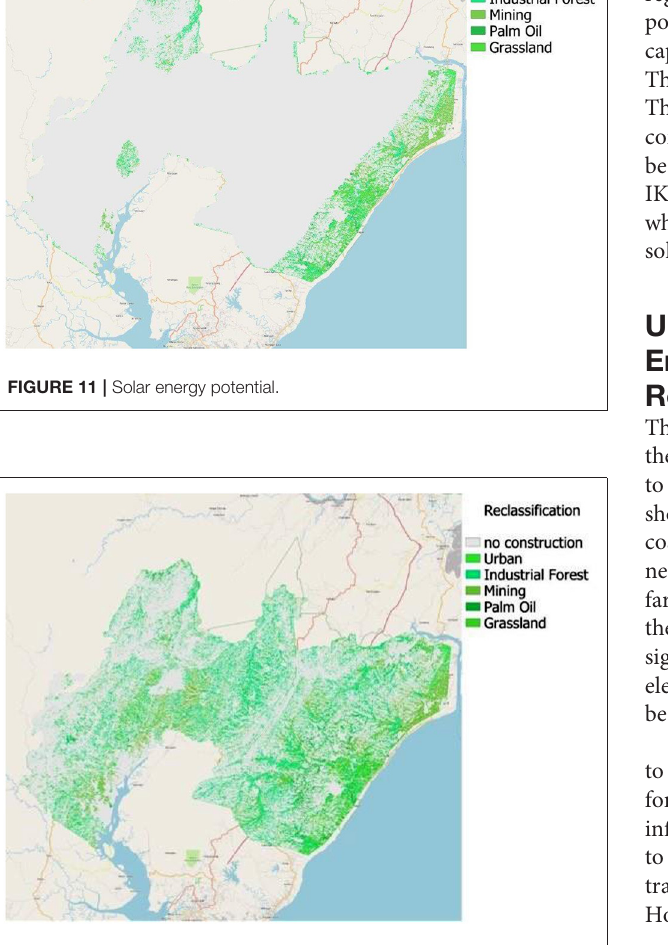
The analysis of the potential from solar energy follows a similar sequence as for wind energy. The first step is to create binary maps based on the solar potential indicators ( Figure 10